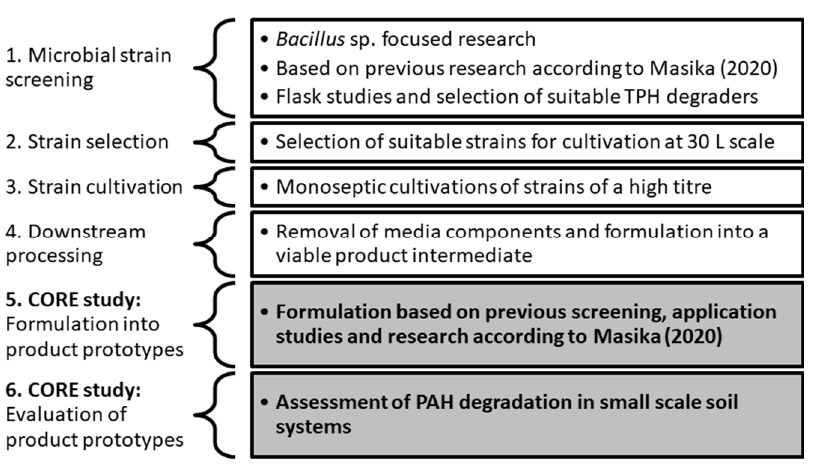
Figure 1. Proposed research design for evaluation of PAH degradation.